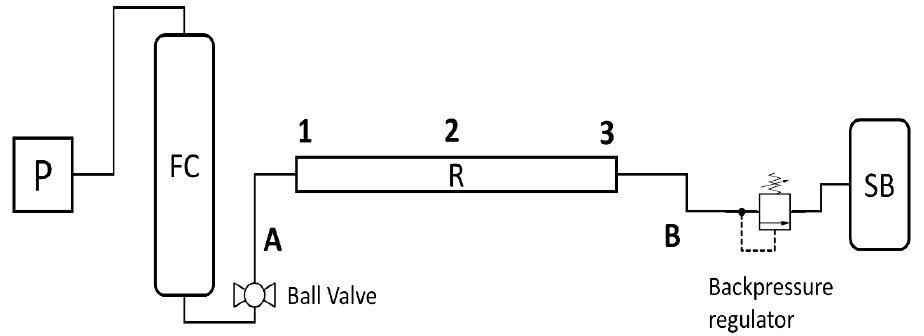
Figure 3. Schematics of the experimental procedure. Feed cylinder (FC), ball valve, inlet section (A), reactor (R), thermocouples (1; 2 and 3), outlet section (B), backpressure regulator, and sampling bag (SB).